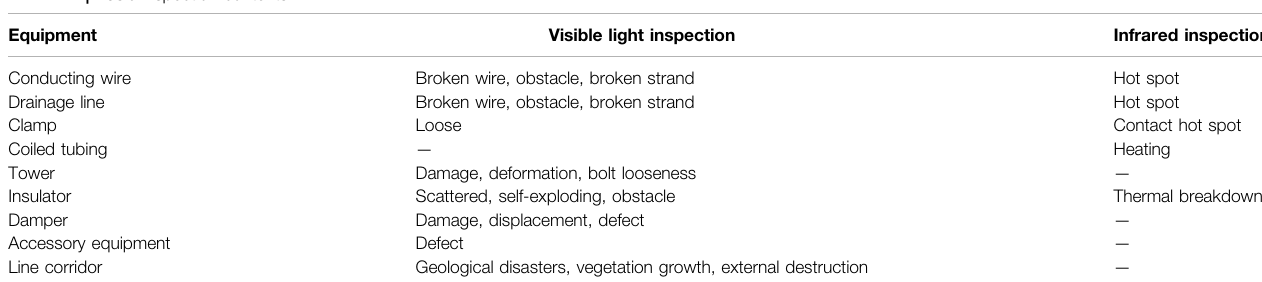
TABLE 4 | Basic inspection contents.